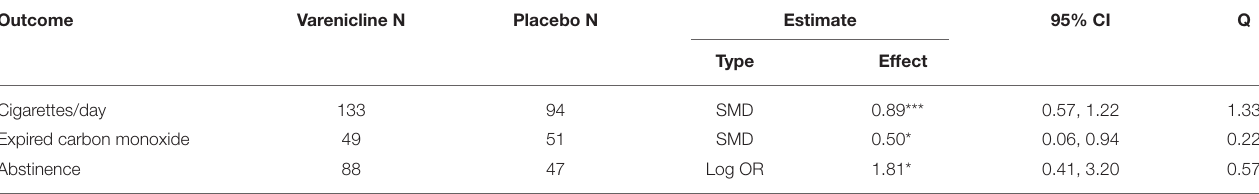
TABLE 5 | Analysis summary of the parameters studied and their